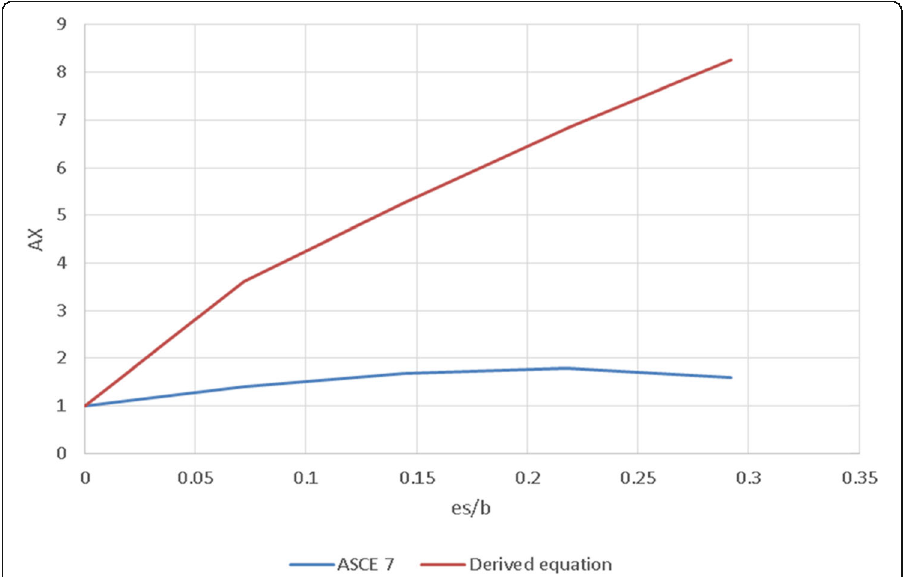
Fig. 48 Comparison of eccentricity ratio — max. A x for ASCE 7-10 and derived